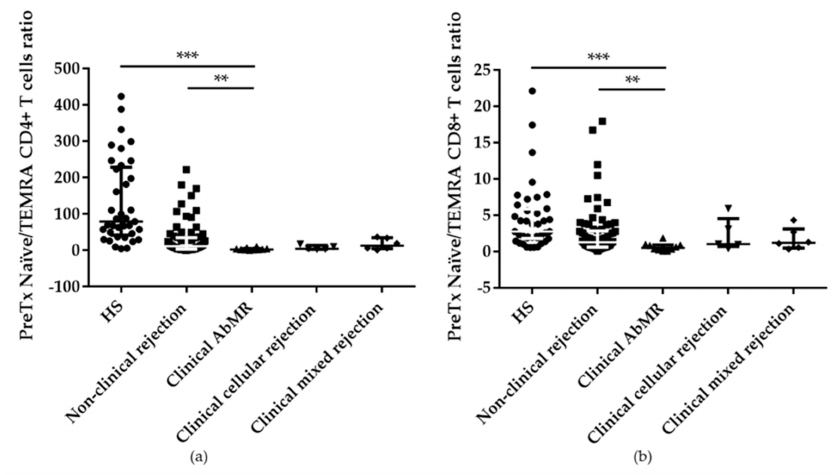
Figure 6. Predominance of a preactivated state in antibody-mediated rejection (AbMR) patients ( n = 11) in comparison with non-rejection group ( n = 87) and healthy subjects (HS; n = 40), reflected o ff by a reduction of pretransplant naïve / TEMRA CD4 + ( a ) and CD8 + ( b ) T cells ratio. ** indicates p < 0.01, and *** p < 0.001